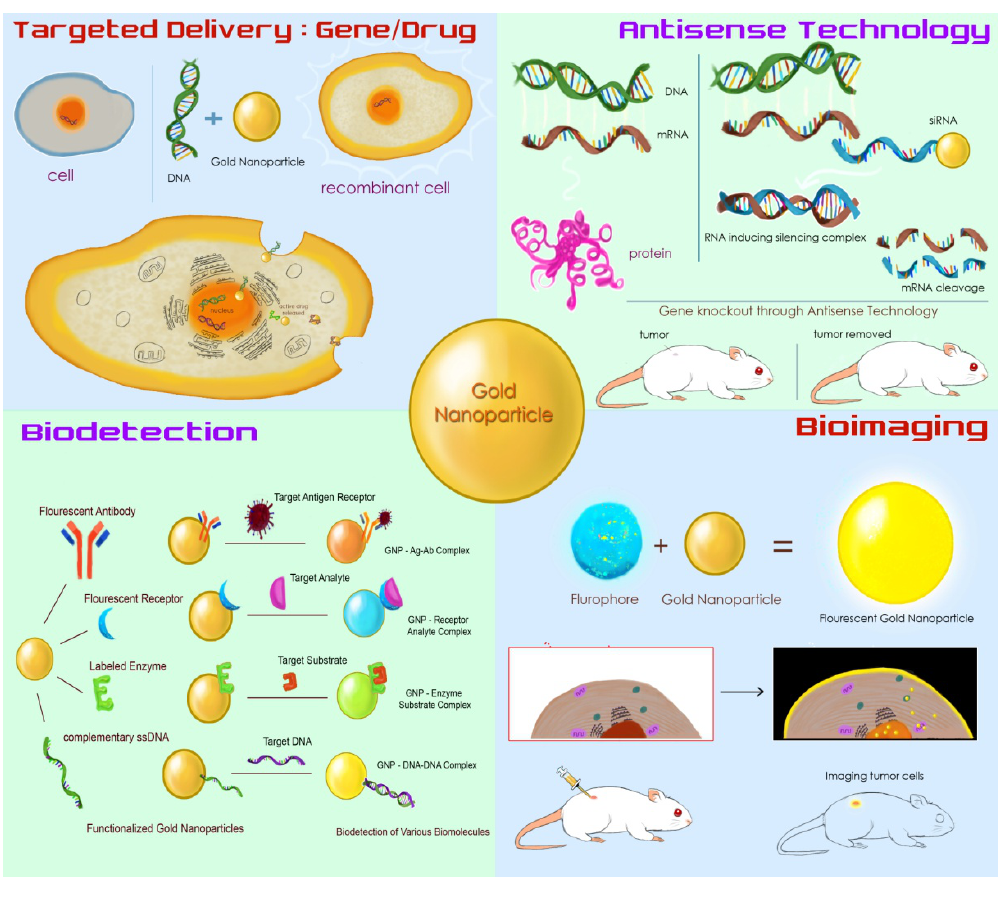
1. Types of functionalization of gold nanoparticles and their potential biomedical